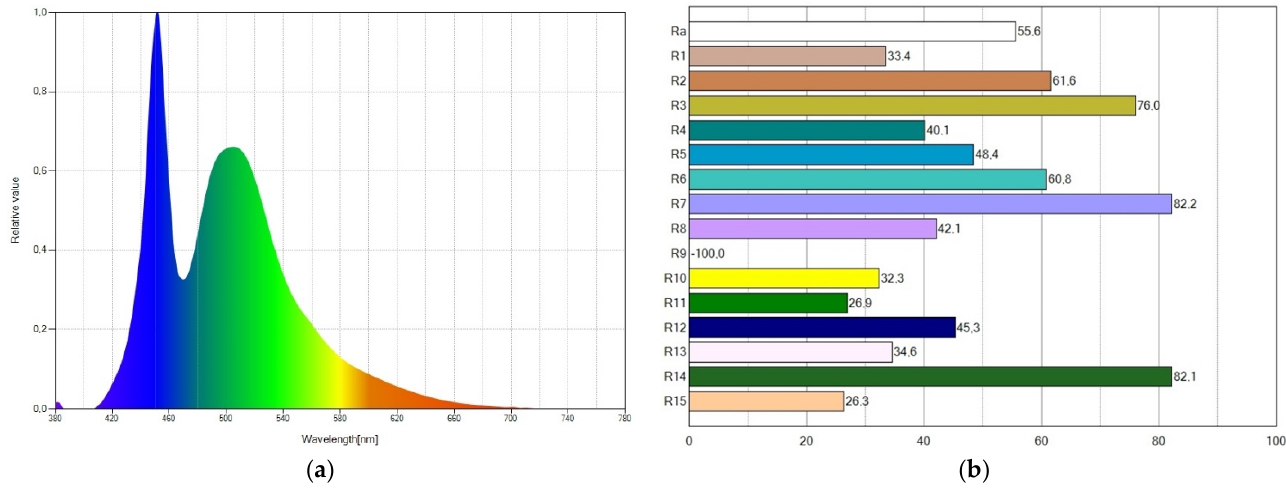
Figure 2. For WLED1, ( a ) spectral power distribution showing a high blue peak and ( b ) CRI values reaching a CRI (R a ) value of 55.6.